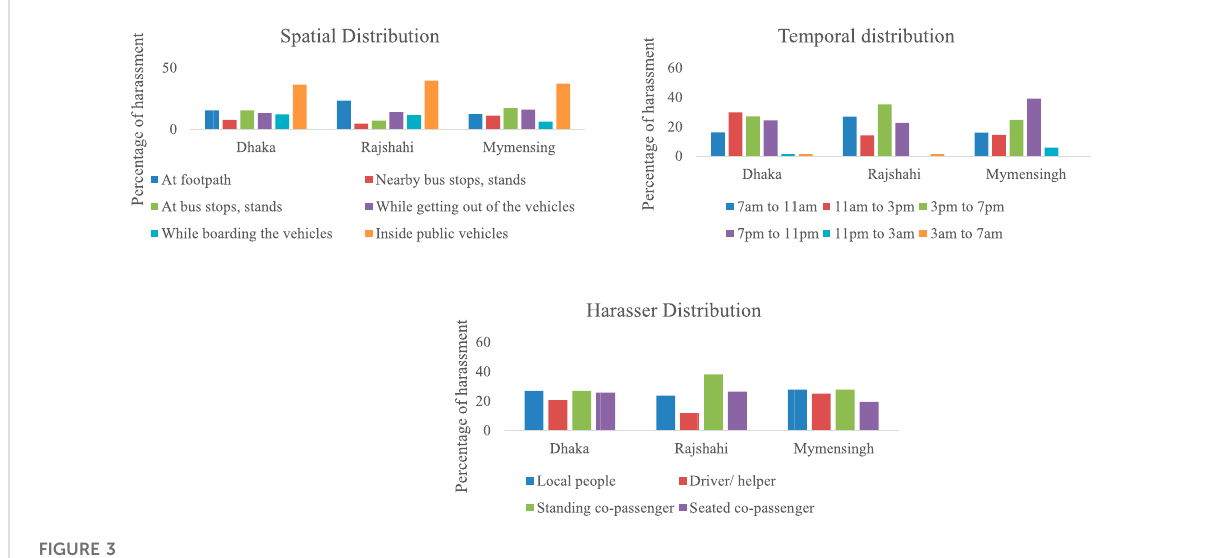
FIGURE 3 Spatial, temporal, and harasser distribution of the harassment